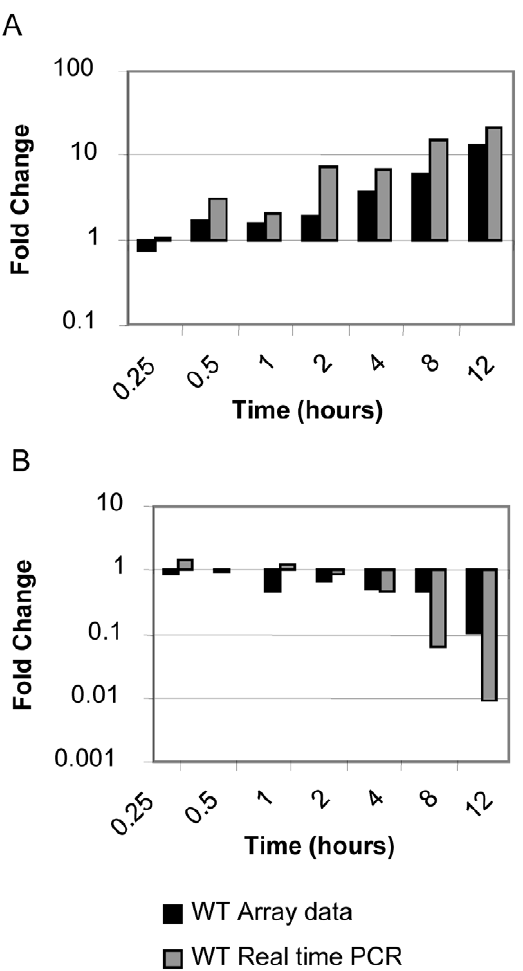
Figure 2. Comparison of gene expression analysis by micro- array with quantitative real time PCR. Microarray (black bars) and qRT-PCR (gray bars) fold-changes for both an up-regulated gene, CCL2 (A) and a down-regulated gene, ApoC3 (B) are represented. The means of 4 independent assays using RNA from ligated ileal loops inoculated with wild type Salmonella Typhimurium (IR715), both microarrays and qRT-PCR, performed in duplicate are shown.